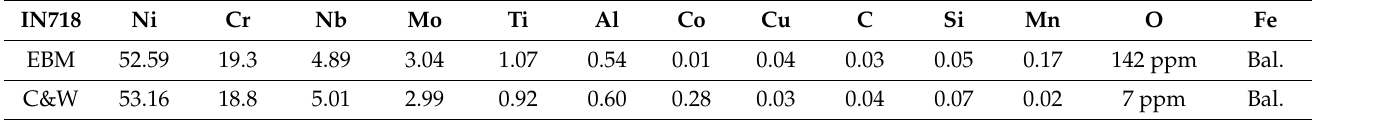
Table 1. Nominal chemical composition of EBM 718 powders (mass %).